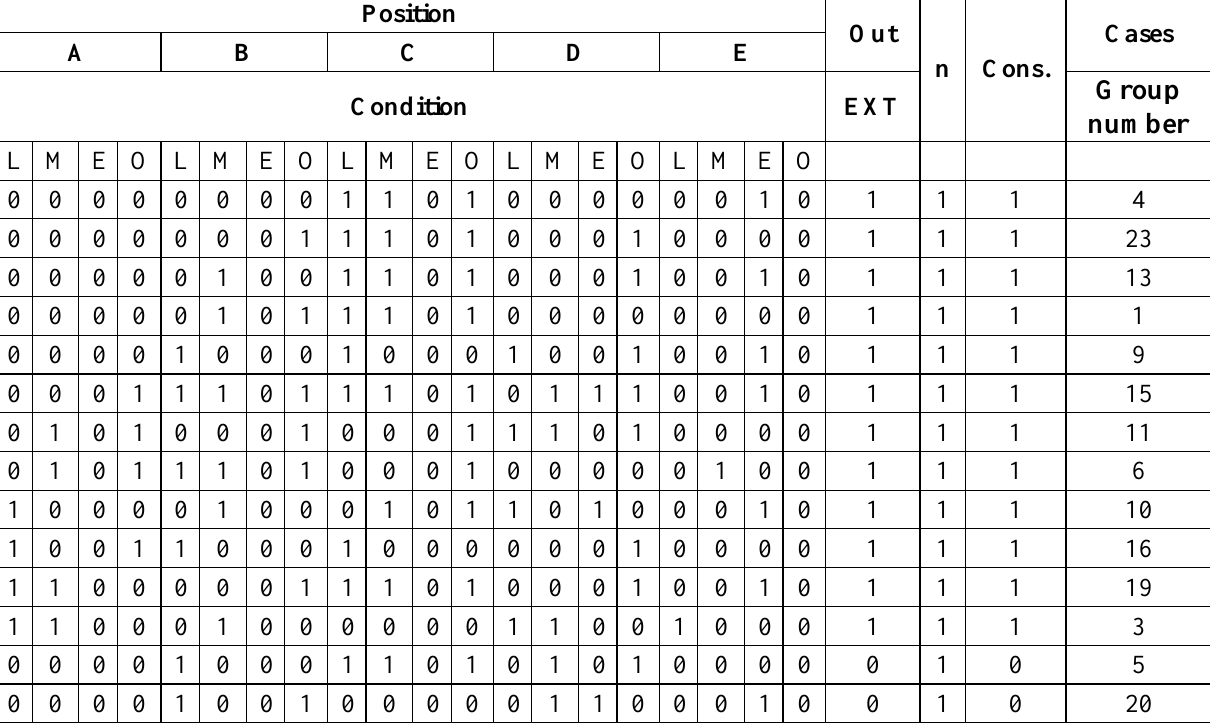
Table A3.8. Truth table of csQCA for the analysis of sufficiency for the group success. Out=Outcome, n=Number of cases, Const=Consistency, L=Leader, K=Knowledge generator, C=Connector, F=Follower, M=Moralist, E=Enforcer,